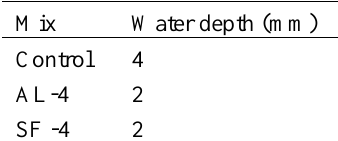
Water permeability